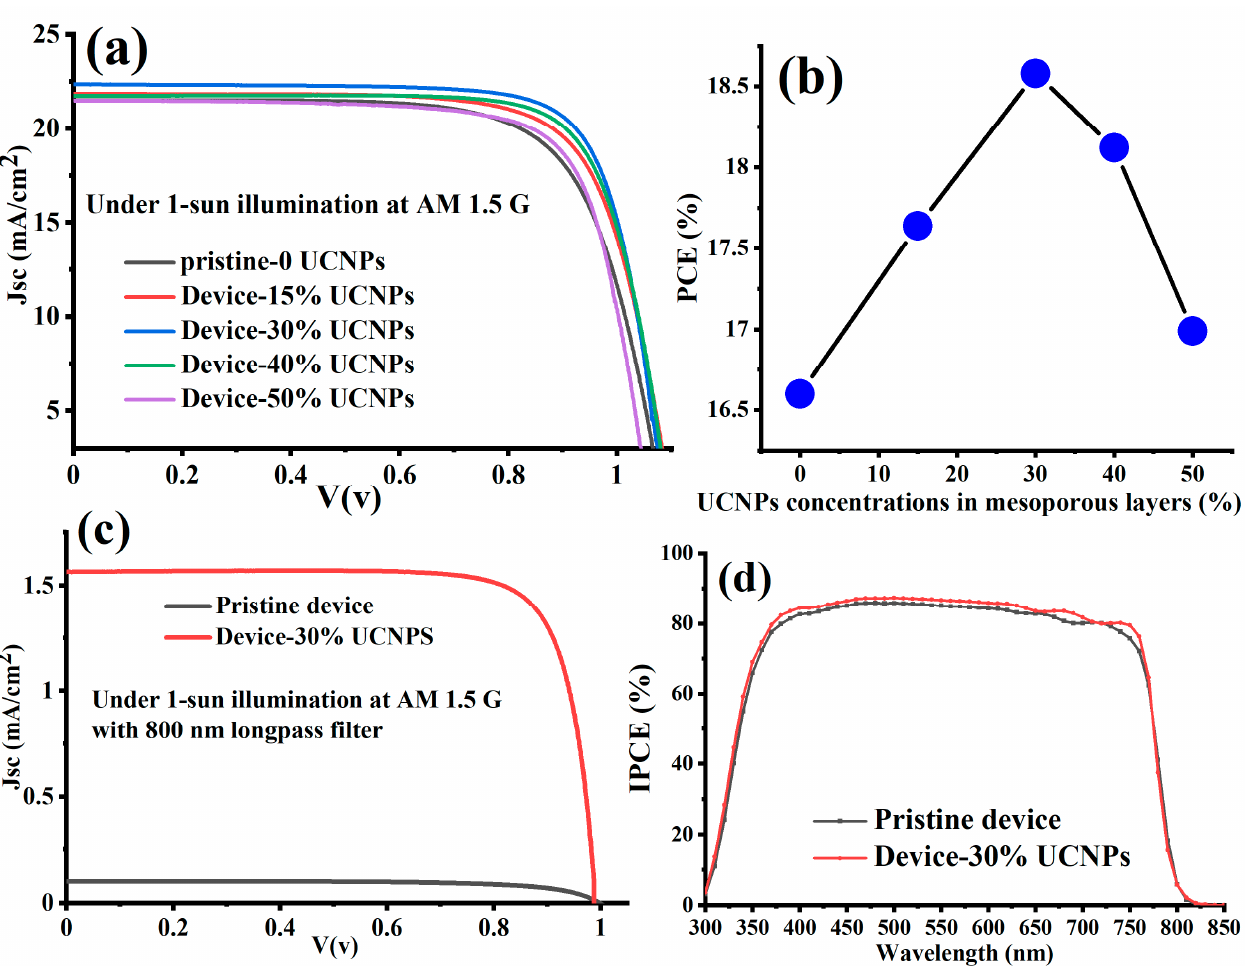
Figure 4. ( a ) J-V characteristic curves measured under AM 1.5 G for fabricated PSCs with and without UCNPs amounts integrated within the mesoporous layers. ( b ) PCE of the fabricated PSCs as a function of the UCNPs amounts integrated within the mesoporous layers. ( c ) J-V characteristics measured under NIR irradiation with 800 nm long-pass filter for device-30% UCNPs and pristine devices. ( d ) Quantum efficiency (IPCE) spectra of device-30% UCNPs and pristine devices.